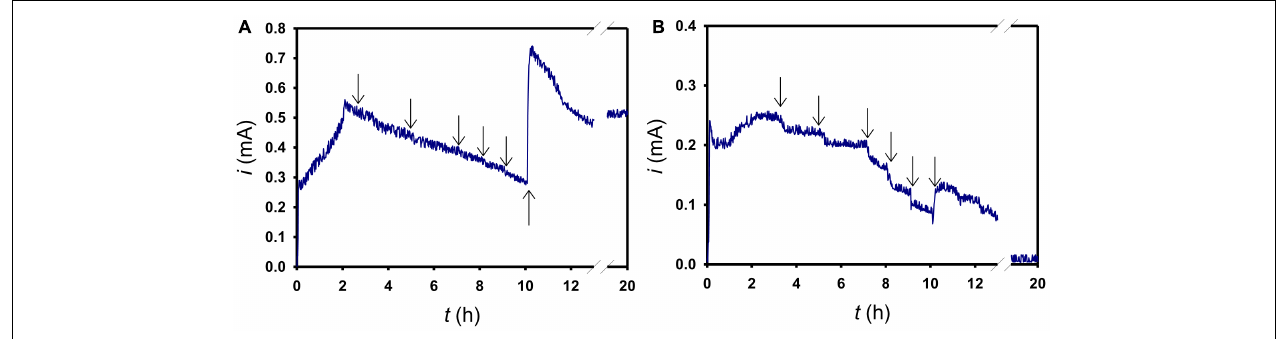
FIGURE 5 | The effects of metabolic inhibitors on the current genration of S. decolorationis NTOU1 utilizing (A) lactate and (B) acetate. The arrows in both figures indicate the 6, 12, 24, 36, 48 mM AcMet, and 6 µ M riboflavin in turn in the electrochemical cell.